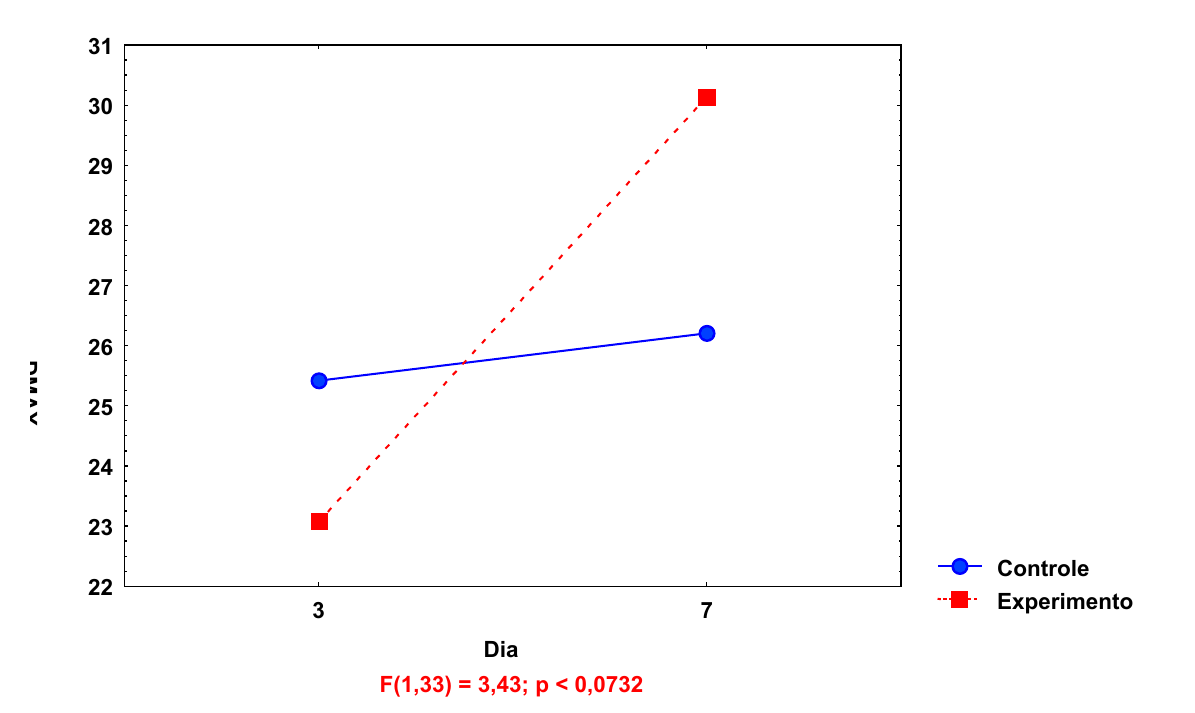
FIGURA 8 – Teste de Anova (análise de variância) para os grupos controle e experimento entre si em relação à deformação máxima